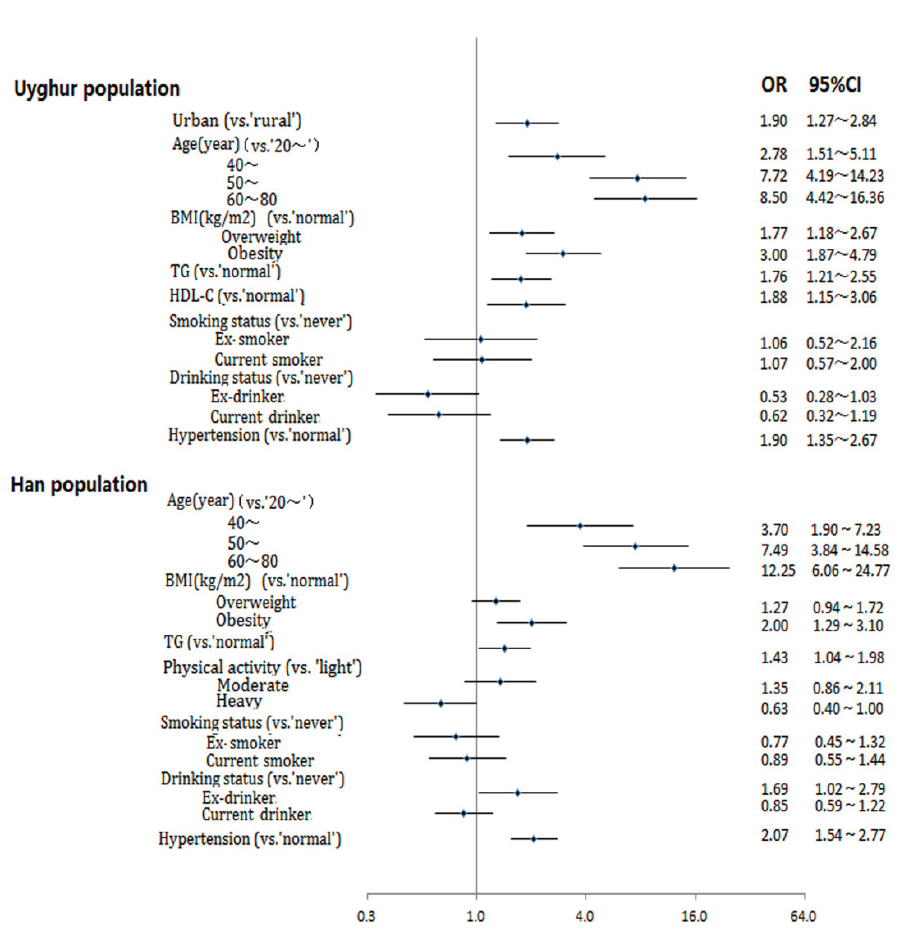
Figure 2. Multivariate logistic regression analysis of risk factors of diabetes in Uyghur and Han